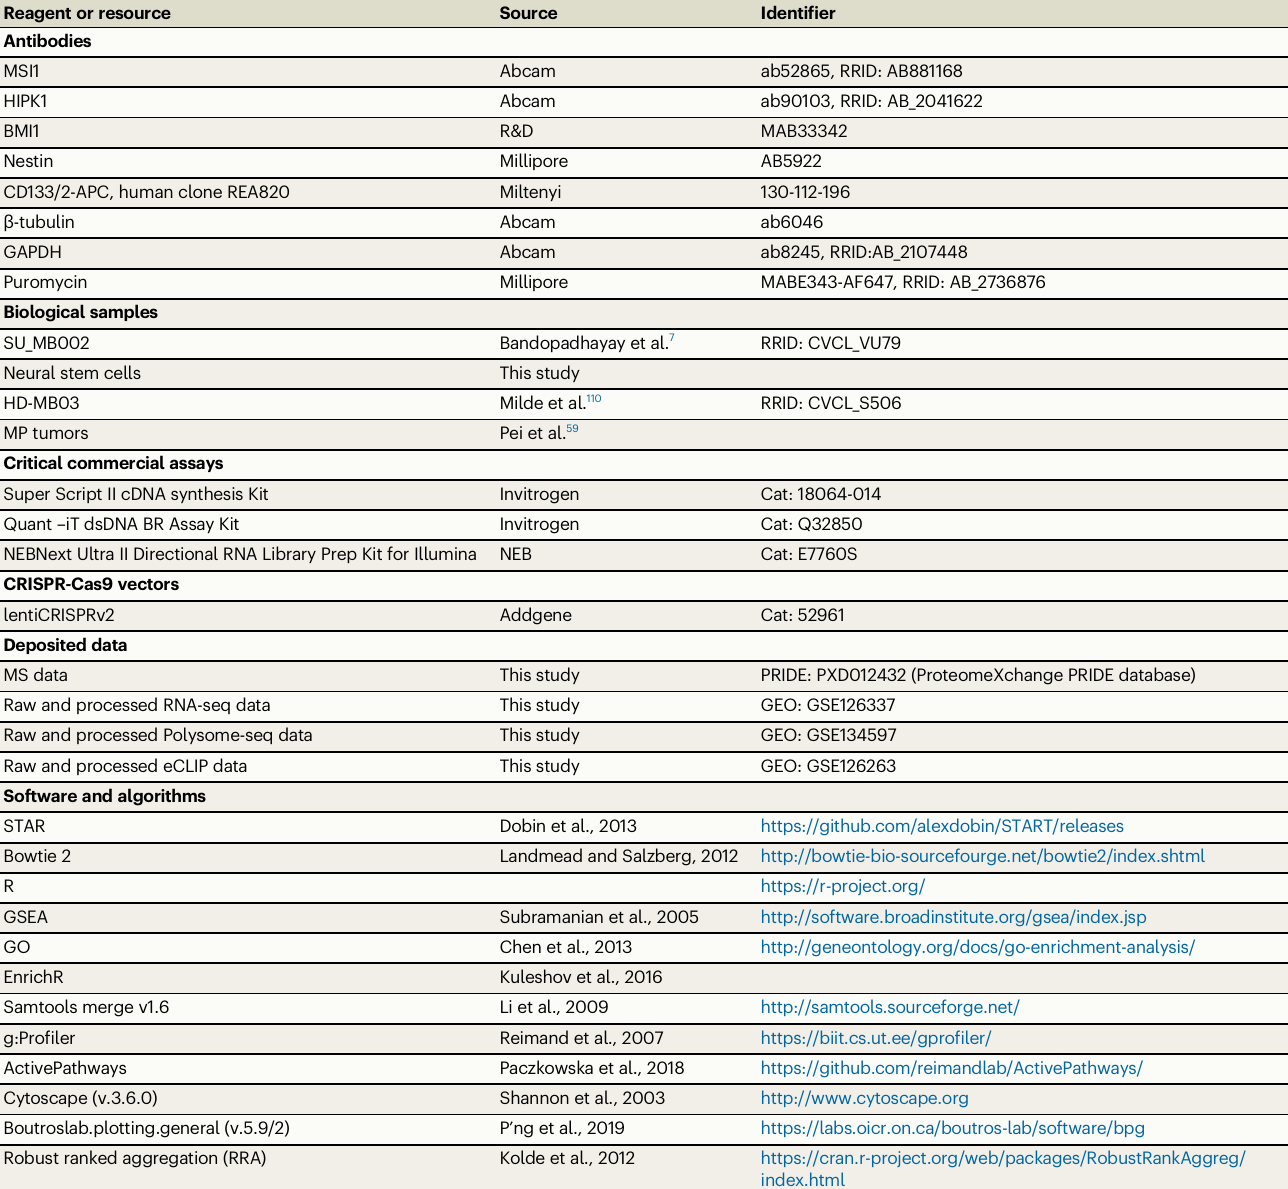
Table 1 | Resource table of reagents, samples, software and algorithms employed Reagent or